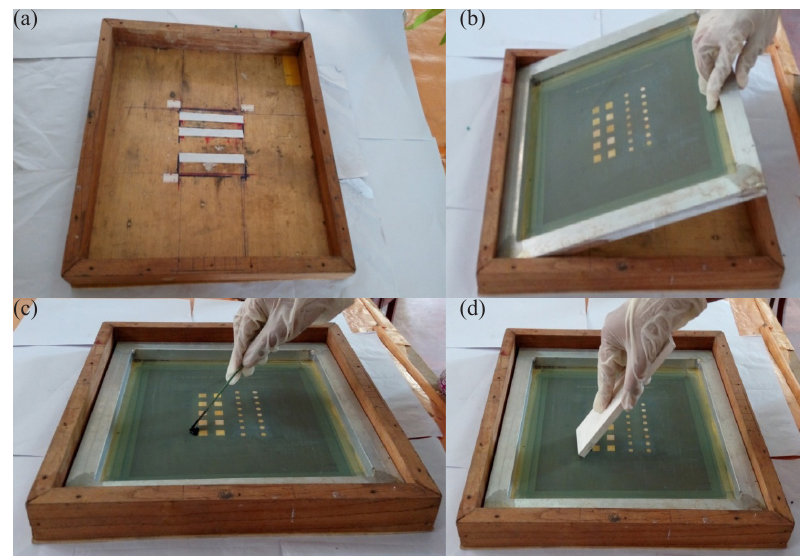
Figure 1: Steps followed in screen printing method; (a) mount FTO glass was inside the frame, (b) place the screen, (c,d) place the slurry on the